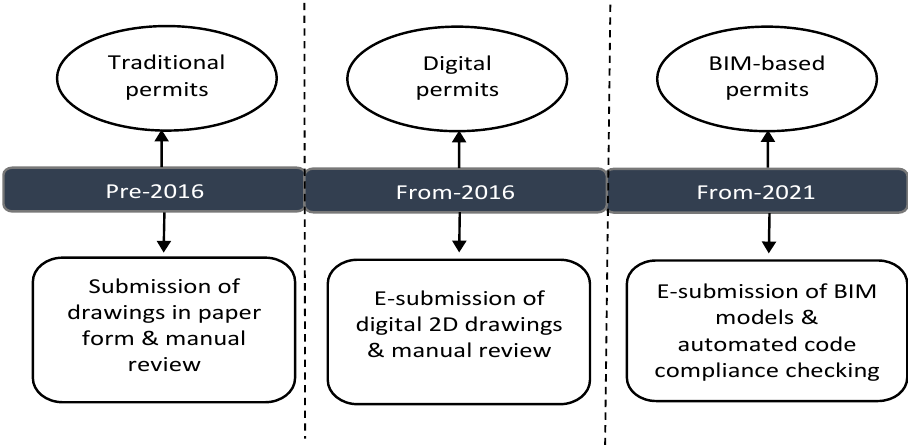
Figure 4. Building permit process transitions in the Tallinn City Government (TCG).